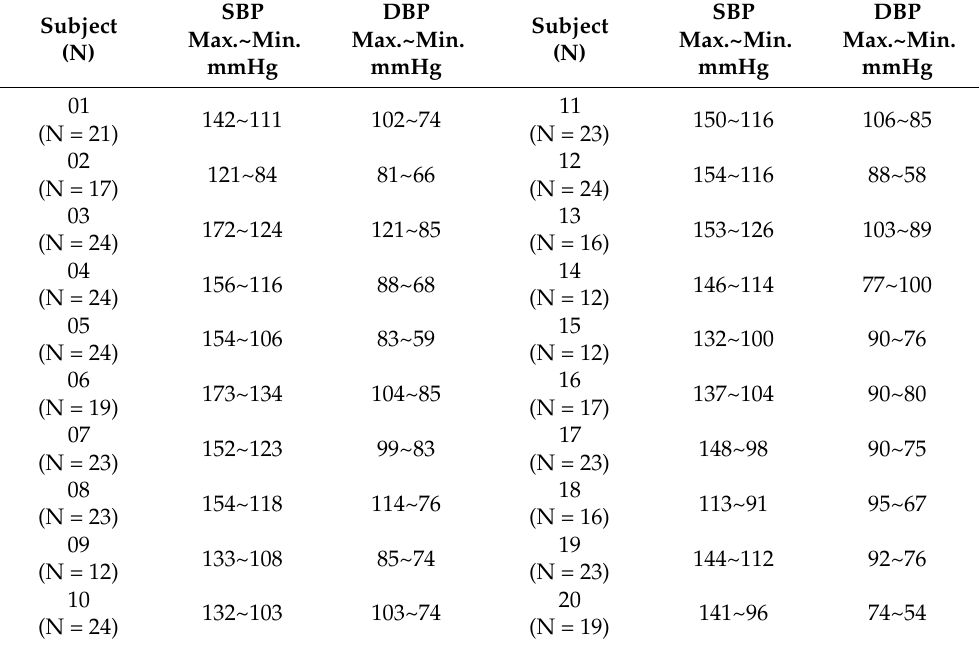
Table 1. The maximum and minimum standard blood pressures of subjects in the four